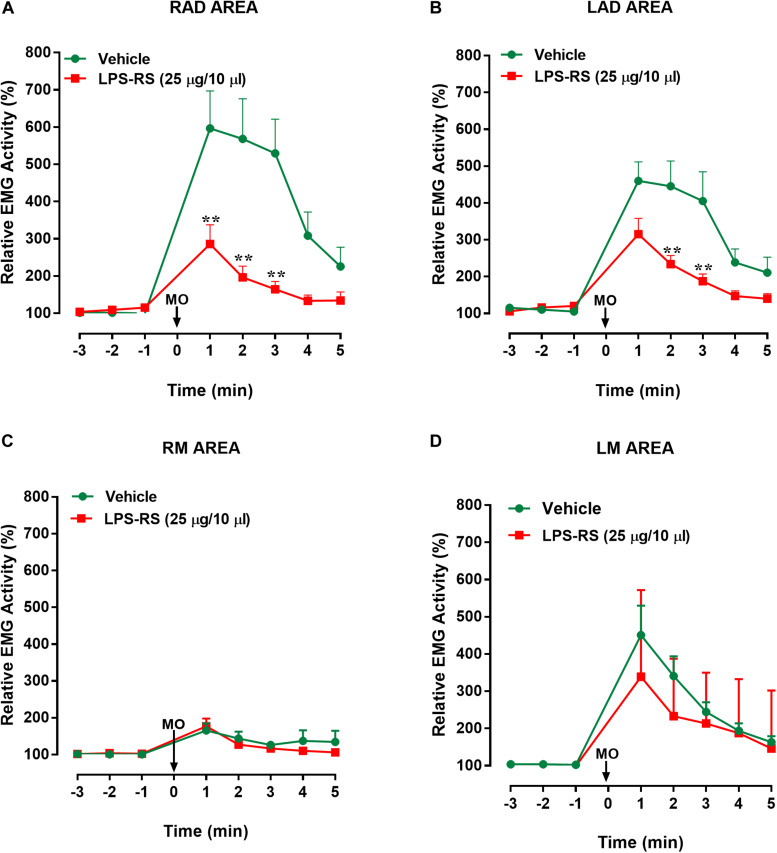
Effects of i.t. application of LPS-RS on the MO-evoked EMG activity expressed as % change from baseline, following the application of MO to the pulp of the right maxillary first molar. Data show the relative EMG activity changes (%) in (A) right anterior digastric (RAD), (B) left anterior digastric (LAD), (C) left masseter (LM), (D) right masseter (RM). The circles indicate data obtained in vehicle-treated animals, and the squares show the effects of LPS-RS (that was applied at 10 min before the MO application). Each point represents the mean ± standard error mean of 10–13 animals per group. ∗∗P < 0.0001 (two-way ANOVA followed by Bonferroni test).